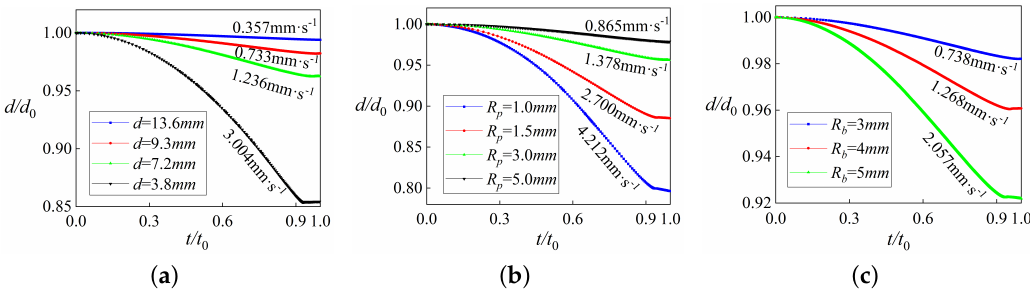
Figure 9. Displacement of particles due to collapsing bubbles for cases with different initial distance between their centers d 0 ( a ), for cases with different particle radius R p ( b ) and for cases with different initial bubble radius R 0 ( c ) in Table 2; the constant velocity is given for each